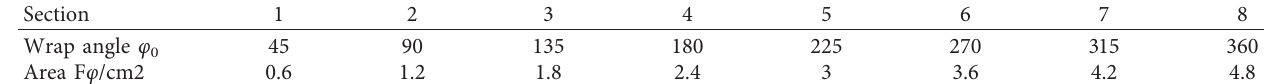
Table 1: The area of each section of the vortex